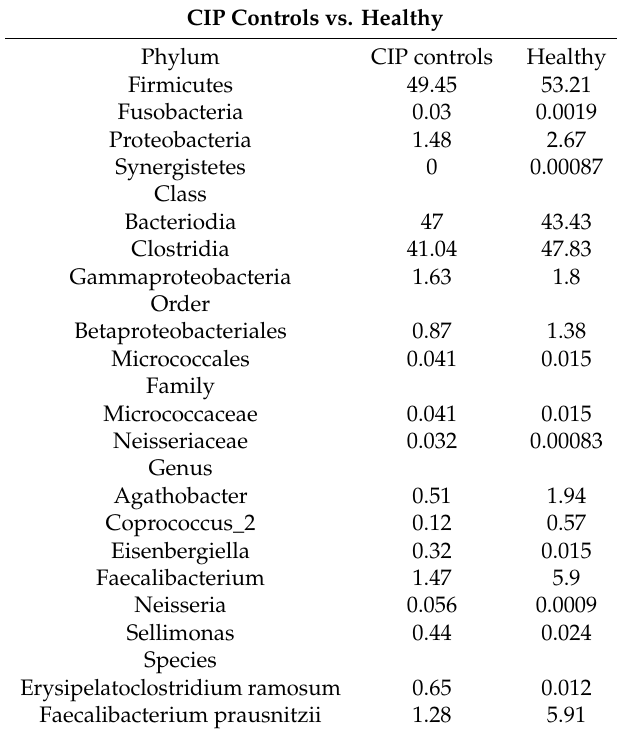
Table 6. Taxonomic di ff erences found with analysis of composition of microbiomes between CIP controls and the healthy group on all taxonomic